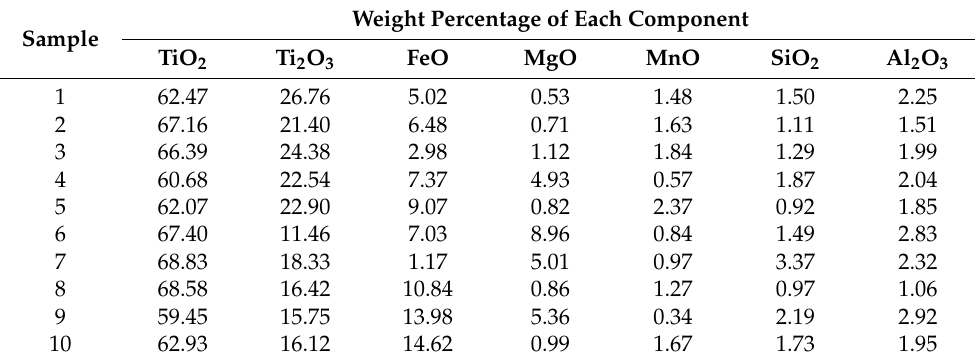
Table 2. Weight (in grams) of each component in the synthetic slag after smelting.